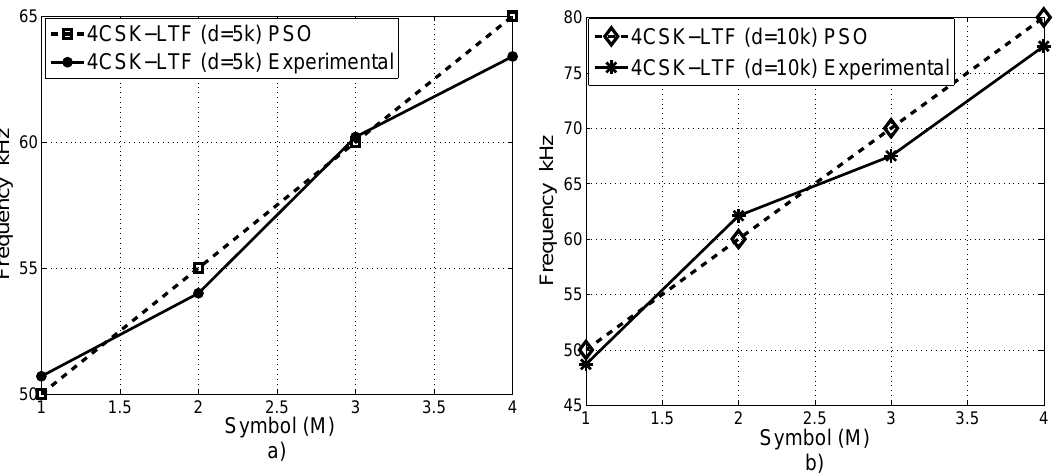
Figure 10. Frequencies obtained by the PSO and experimental system for 4-CSK-LTF with ( a ). d min = 5 kHz and ( b ). d min = 10